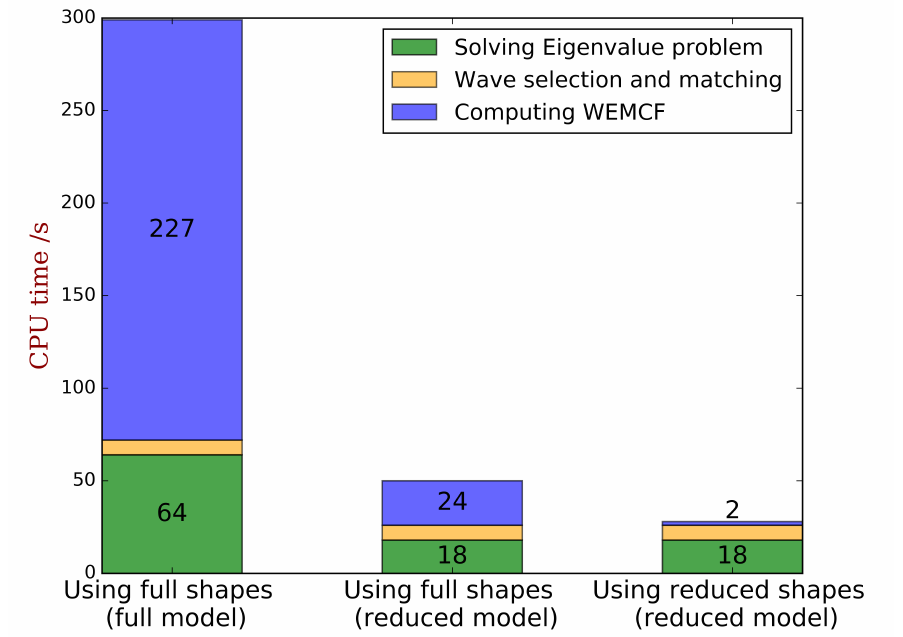
Figure 8. CPU time for the full dispersion characteristics with WFEM of unit cell A by the energy formula K 2 where the energies are calculated by: (1) using full shapes obtained from full WFEM; 1f (2) using full shapes obtained from reduced WFEM; (3) using reduced shapes. The label ’Wave selection and matching’ refers to the standard post-processing of the WFEM results in order to identify the same type of wave among different frequencies [36], not the matching between the results between the OC and SC status as required for computing the frequency formula of